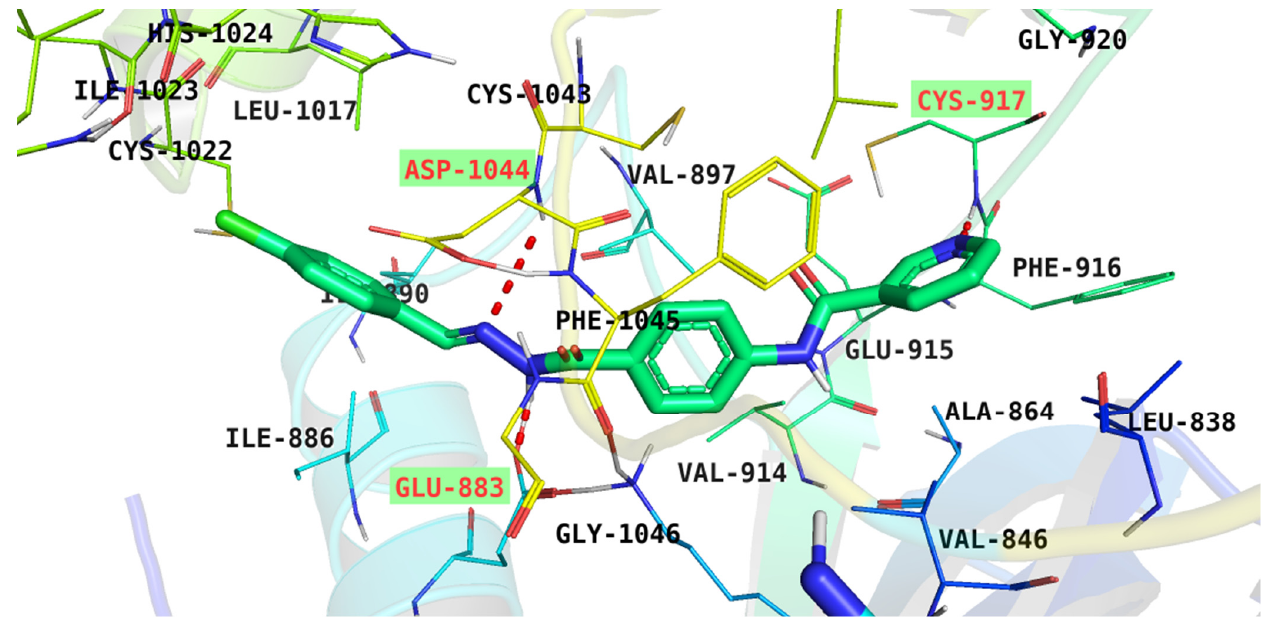
Figure 7. Binding pattern of compound 6 showing three H ‐ bonds with Cys917, Asp1044, and Glu883 in addition to many HI interactions with Phe916 and Ile886. Table 5. Binding score of the synthesized compounds against VEGFR-2. Comp. ∆